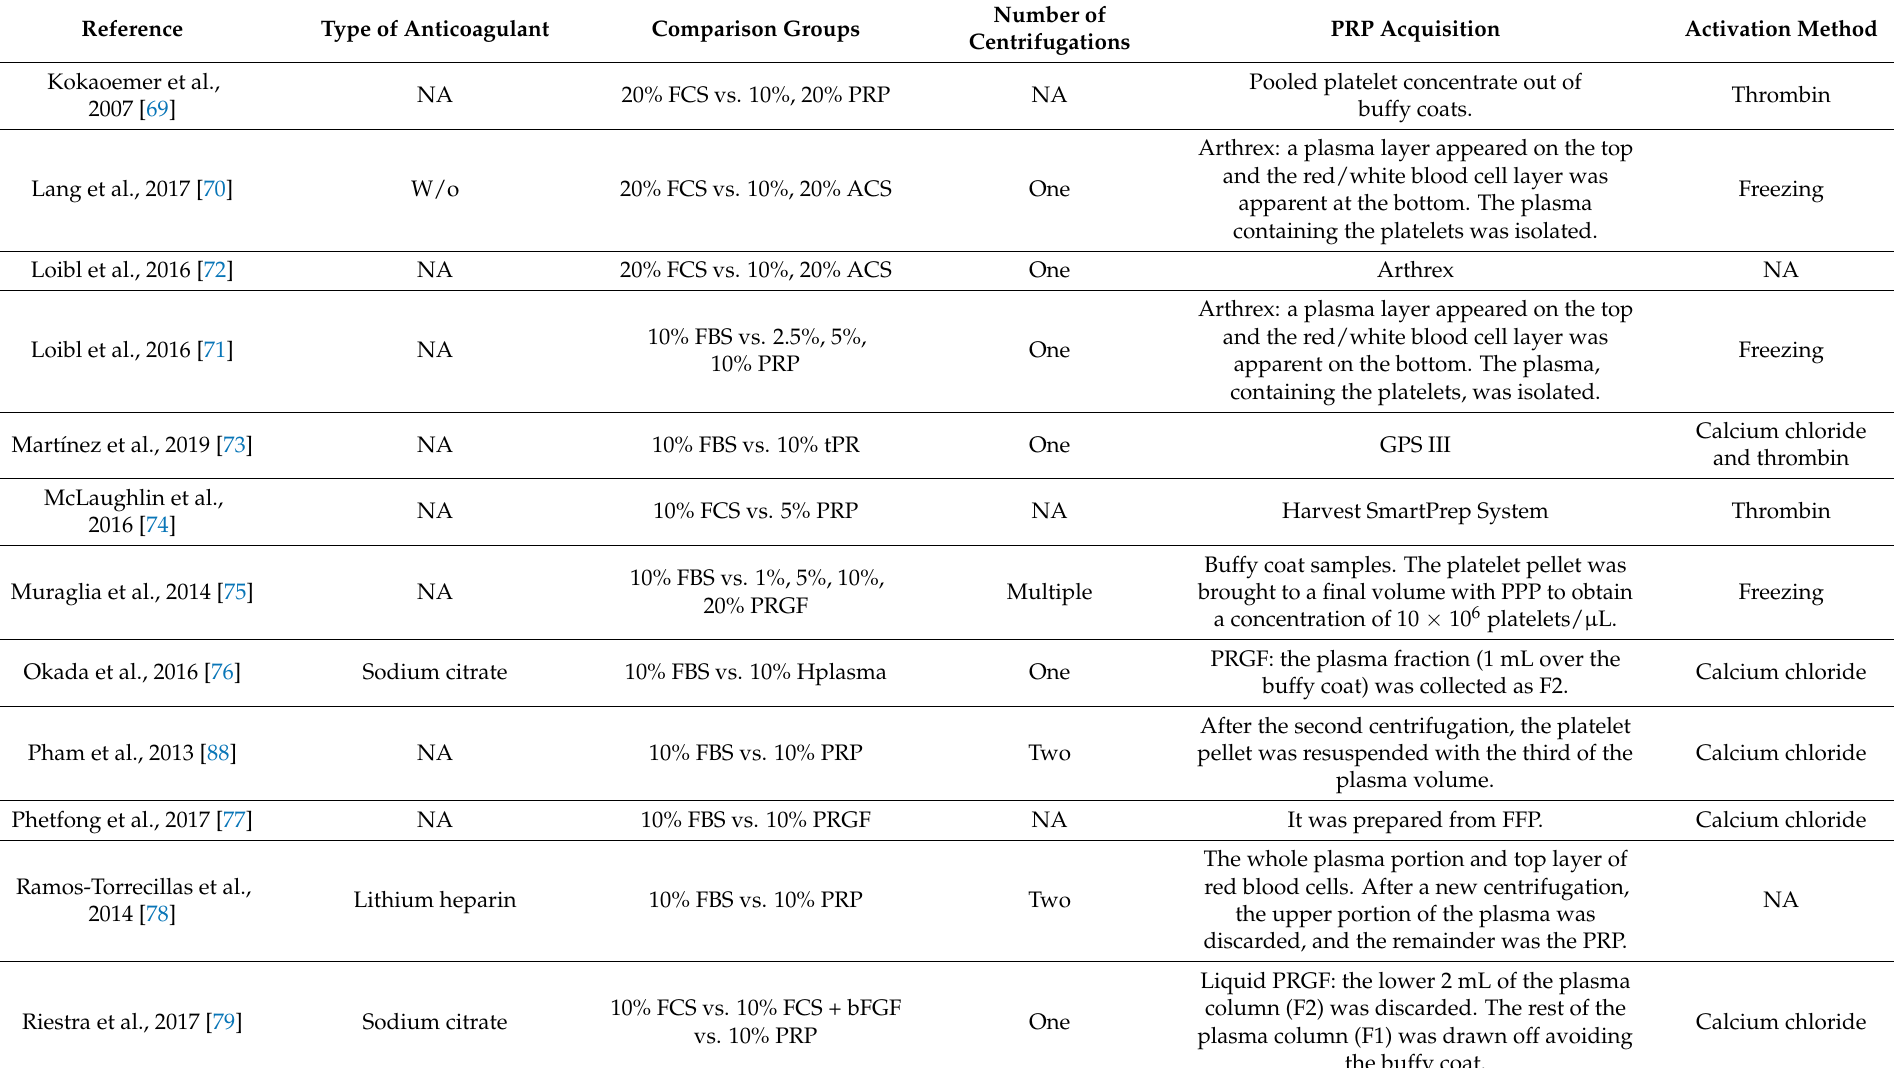
The whole plasma portion and top layer of red blood cells. After a new centrifugation, the upper portion of the plasma was discarded, and the remainder was the PRP. Liquid PRGF: the lower 2 mL of the plasma column (F2) was discarded. The rest of the plasma column (F1) was drawn off avoiding the buffy